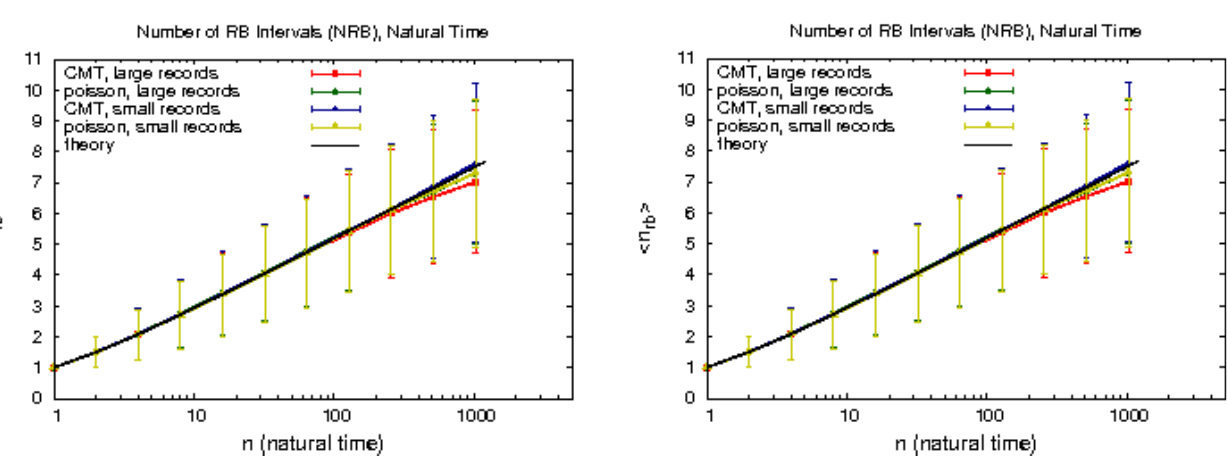
Fig. 1. Mean numbers of record-breaking intervals h n rb i and their standard deviations are given as a function of event number n (nat- ural time). Results are given for the longest and shortest intervals from the CMT catalogue and the synthetic random catalogue. Also included is the theoretical prediction for an iid process from Eq. (4).